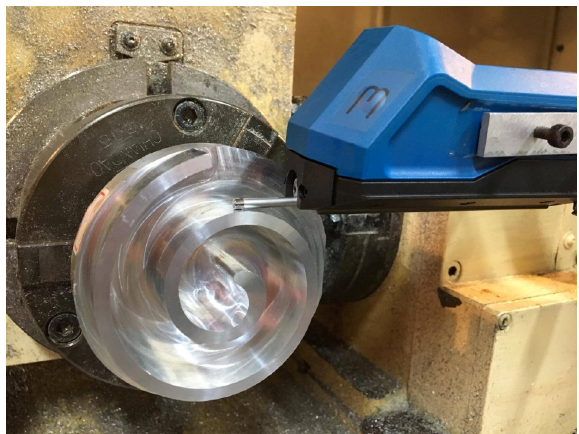
Figure 17. Measurement of the surface roughness of scrolls. Table 9. Measured values, means, and S/N ratios of profile errors.